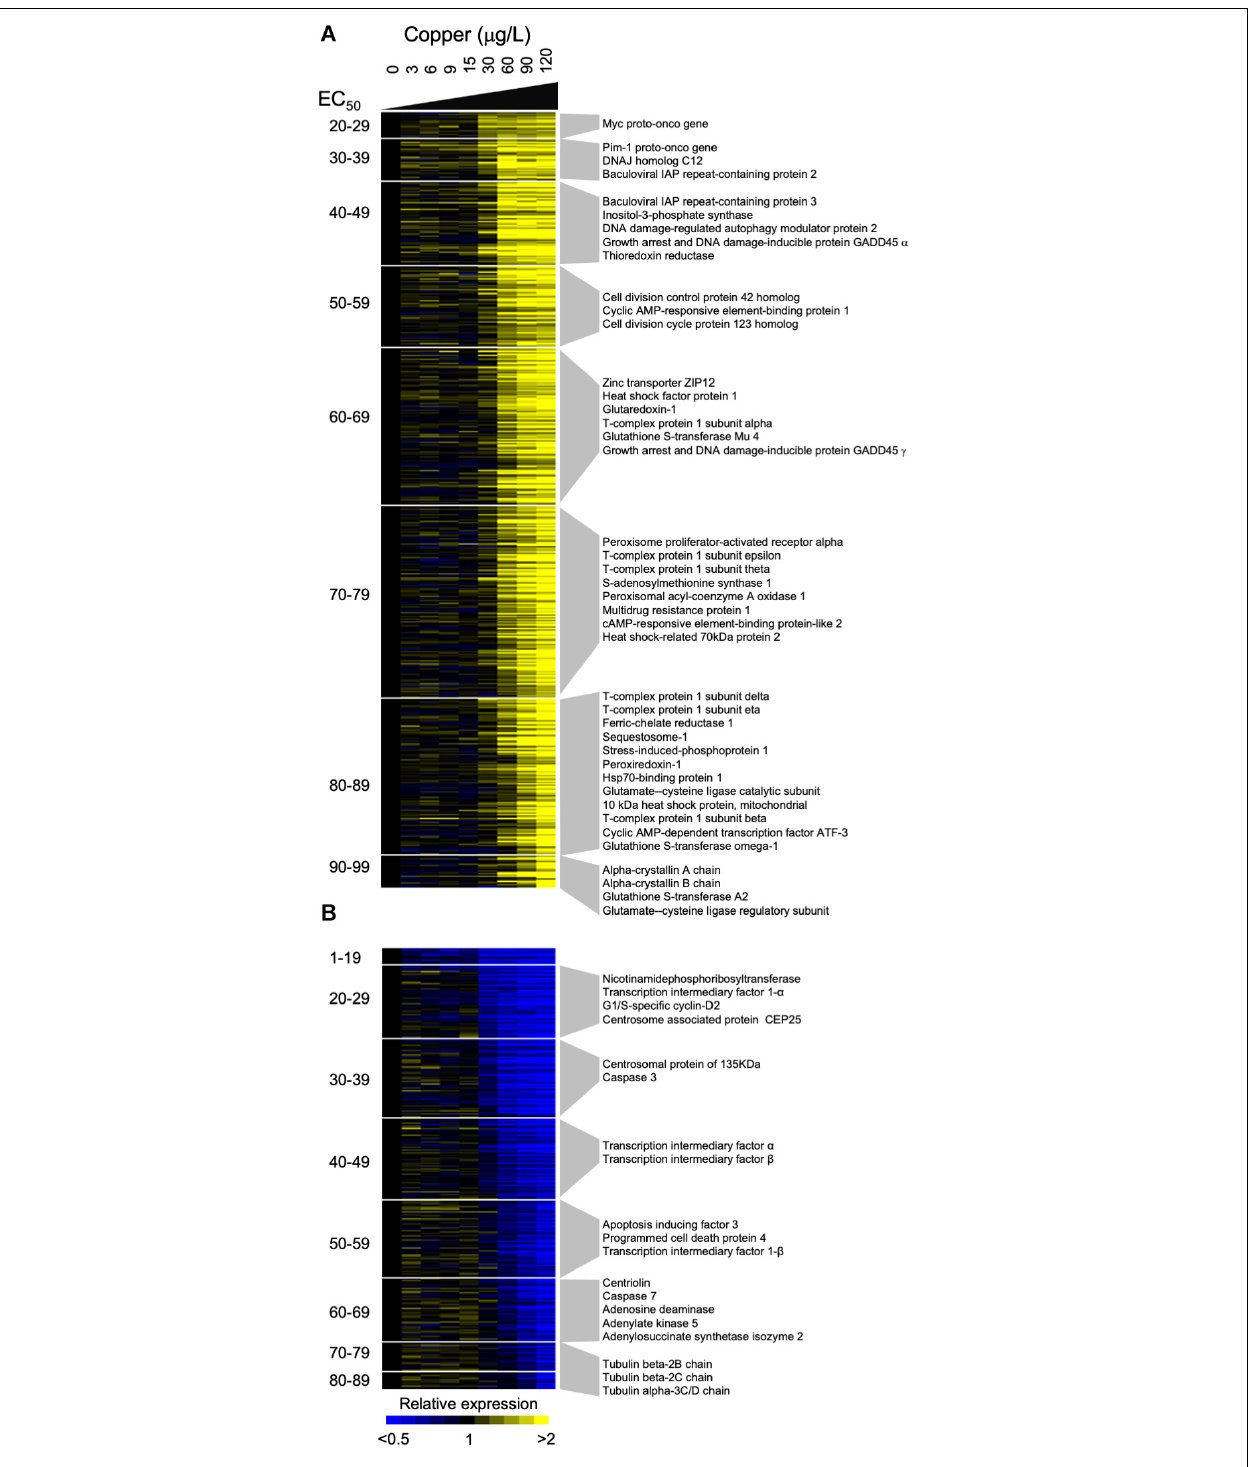
FIGURE 4 | Gene expression dose response profiles detected in gill tissue of adult Mytilus californianus exposed to increasing concentrations of copper. Heatmaps depict induced (A) and repressed (B) genes that exhibited a statistically significant sigmoidal transcriptional dose response. Each row corresponds to a single gene and each column corresponds to a particular concentration of copper. The average expression of each gene at each concentration is represented by a color, with yellow or blue indicating that the gene is up-regulated or down-regulated relative to the expression observed in control mussels. The genes are ranked and grouped according to their observed EC50 value, with more responsive transcripts located at the top of each heatmap. Selected genes whose expression may be pertinent to the response to copper are indicated next to each grouping.